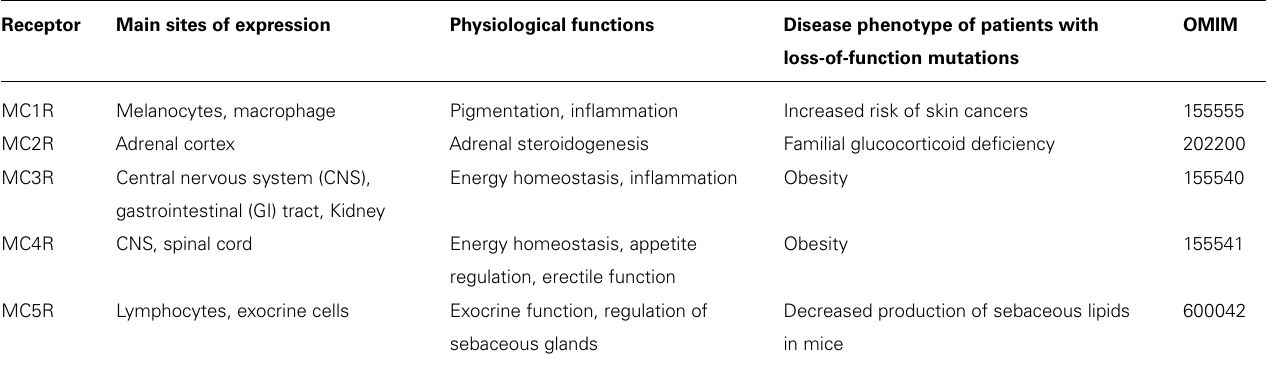
Table 1 |The members of the melanocortin receptor family, expression, action, and phenotype of individuals with